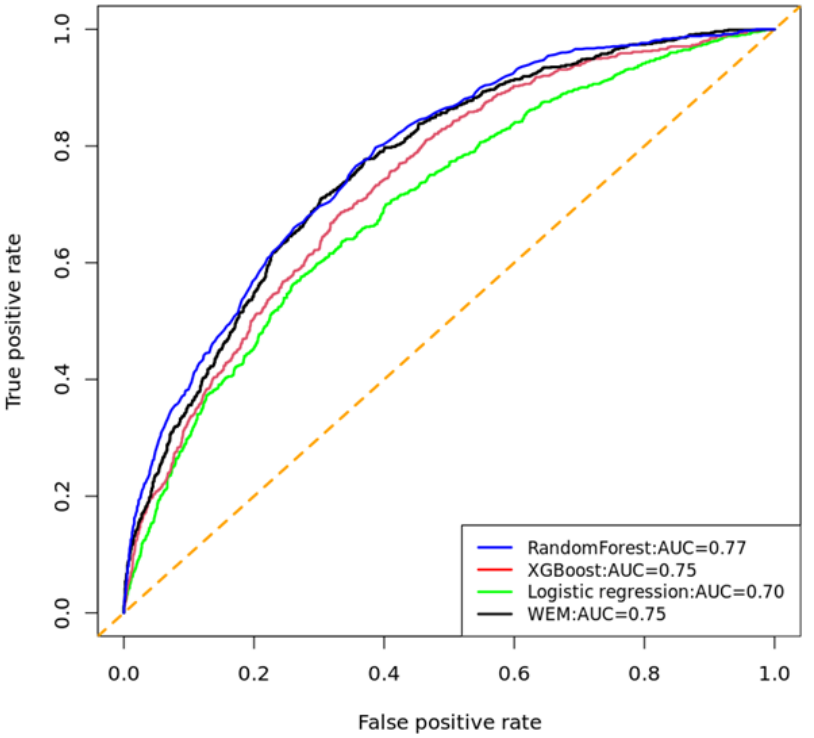
Figure 3. Comparison of receiver operating characteristic (ROC) curves of the ML models imple- mented to predict UDM in AoU, 2023. AUC: area under the curve. The diagonal line dotted in orange indicates that true positive rate is equal to false positive rate.